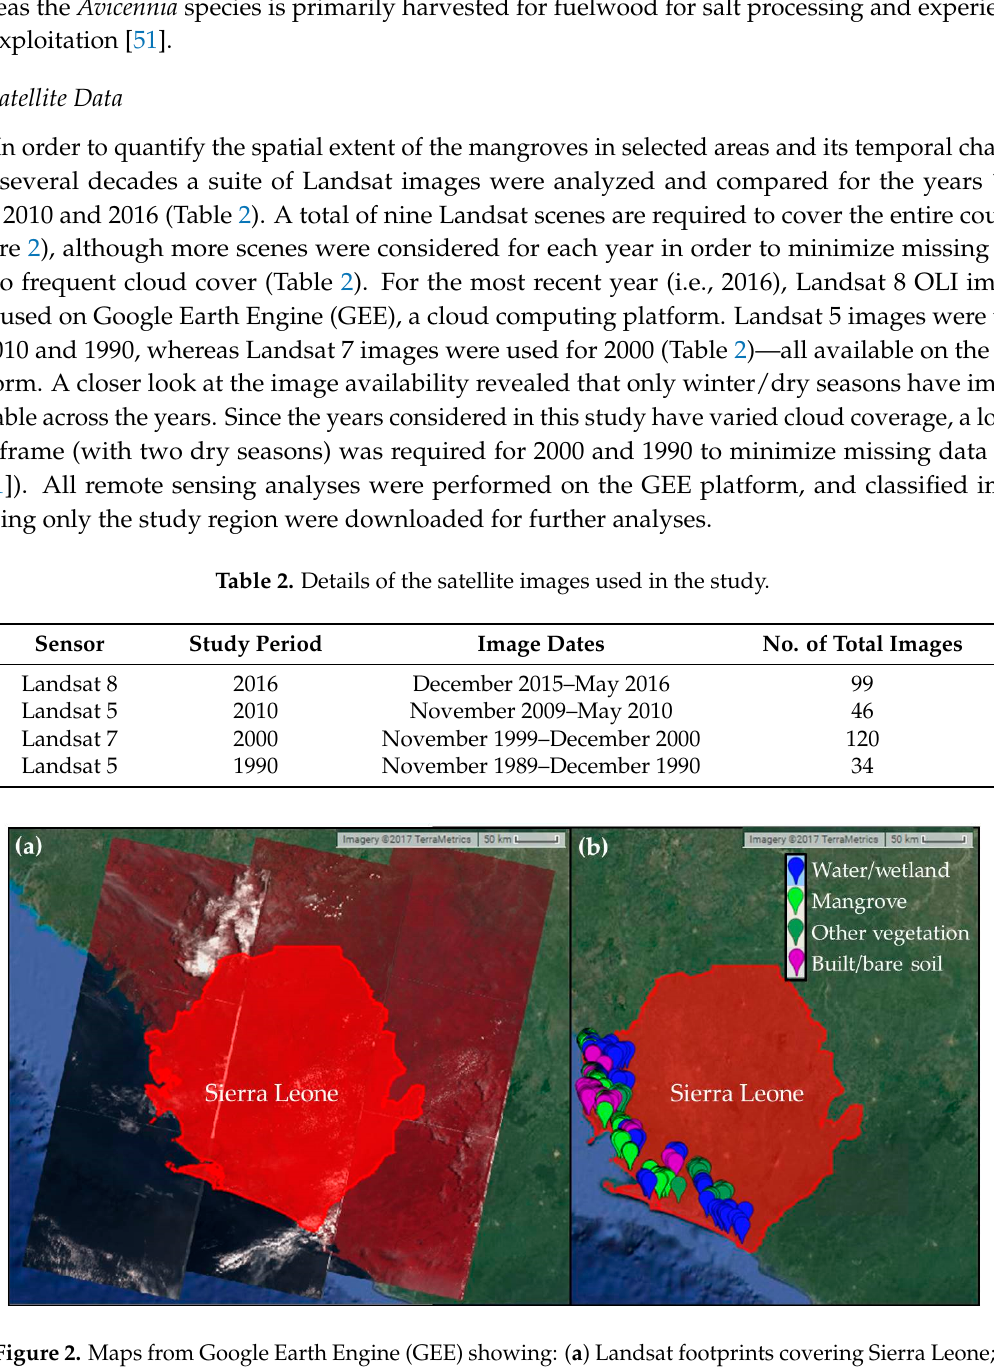
values for each band (spatial resolution: 30 m for visible and infrared bands). Calibration coefficients